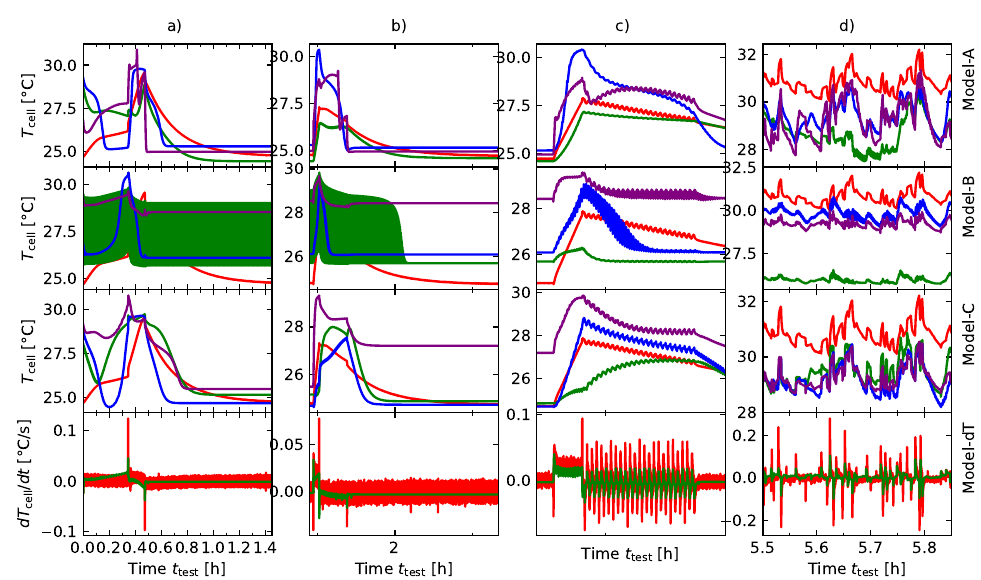
Figure 12. Predicted values of all models in four subfigures are given for the testing data set. Model-A to Model-C show ground truth, Bayesian #1, Bayesian #2 and the most promising individal results. Model-dT illustrates ground truth and the predicted values of the dT-Model. Four areas are marked from ( a – d